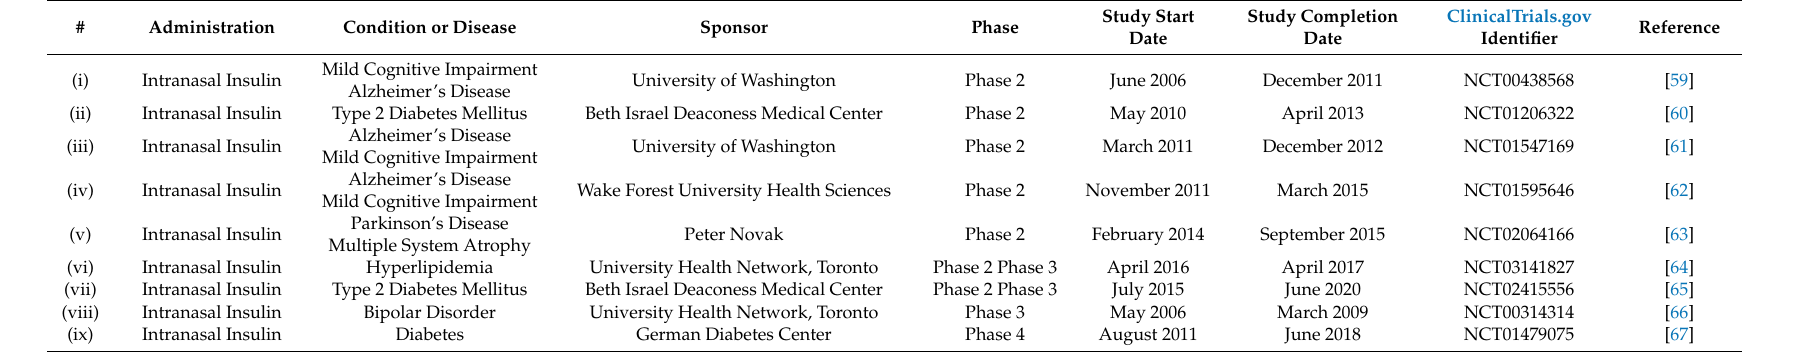
Table 1. Representative clinical trials focusing on intranasal insulin